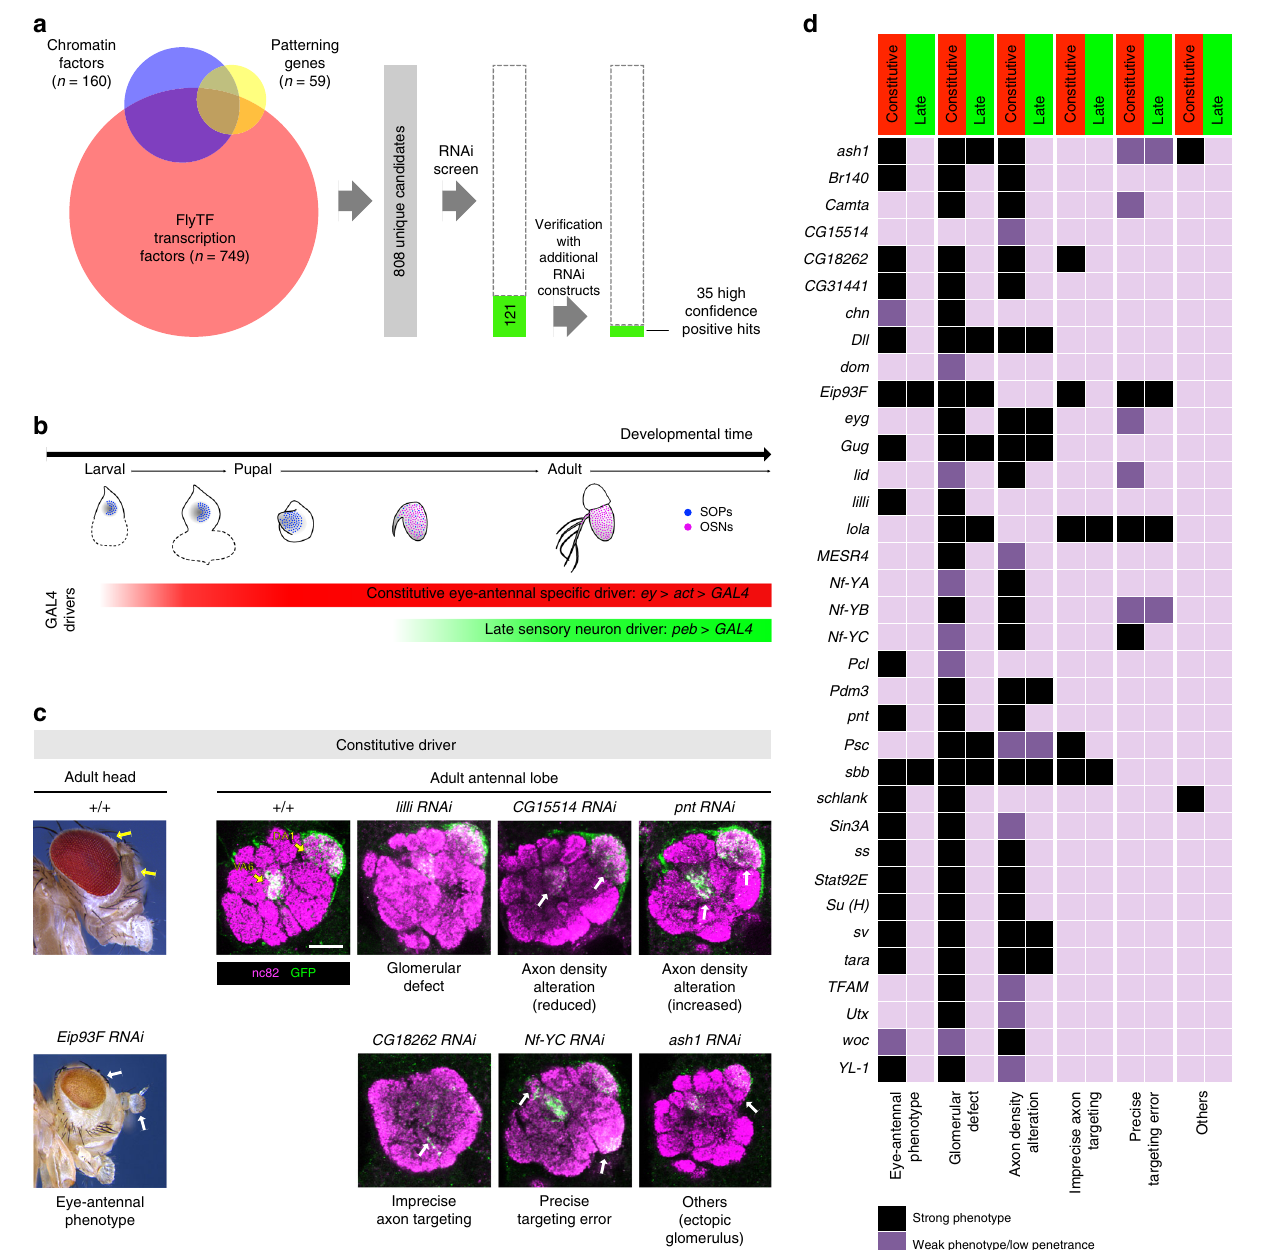
Fig. 6 An RNAi screen for molecular determinants of at1 lineage development. a RNAi screen work fl ow: two rounds of screening, starting from 808 candidate genes (see Methods) identi fi ed 35 genes that showed reproducible defects in antennal development. b Temporal expression of GAL4 driver lines used for RNAi: the constitutive driver, comprising ey-FLP and an actin-GAL4 fl ip-out cassette, is expressed speci fi cally in the eye-antennal tissue from the second instar larval stage onwards, spanning SOP speci fi cation, divisions and OSN differentiation (red bar). The late peb-GAL4 driver is expressed only after OSNs begin to differentiate (green bar). c Examples of the six phenotypic categories. Left: lateral view of the fl y head, with the eyes and antennae marked by arrows. When Eip93F RNAi is induced with the constitutive driver, both antennae and eyes display morphological defects, in addition to loss of eye pigmentation. Right: right antennal lobes of control and the indicated RNAi animals expressing an Or67d -CD8a:GFP reporter (green), which labels the axons of the Or67d and Or82a OSNs that innervate the DA1 and VA6 glomeruli (yellow arrows), respectively. RNAi phenotypes of speci fi c genes with the constitutive driver include global glomerular morphology defects, axon density alteration, imprecise axon targeting, precise targeting errors and/or other defects (indicated by the white arrows). Scale bar = 20 µ m. d Phenotypic classi fi cation of the 35 high con fi dence screen hits when the RNAi transgenes were driven by either the constitutive or late driver. Each gene is classi fi ed under six phenotypic categories in three levels of phenotypic